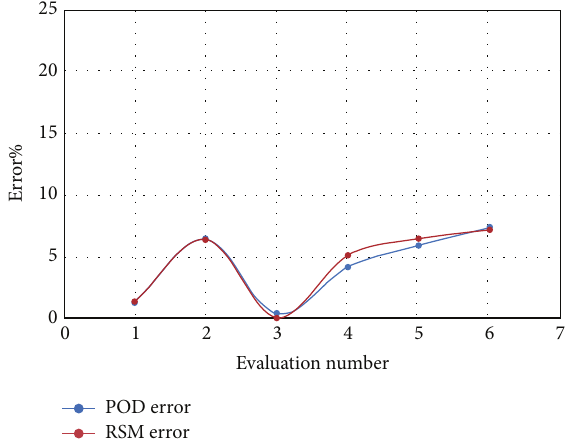
Figure 16: Comparison between RSM and POD method. Recon- struction of the lift coefficient 𝐶 𝑑 .